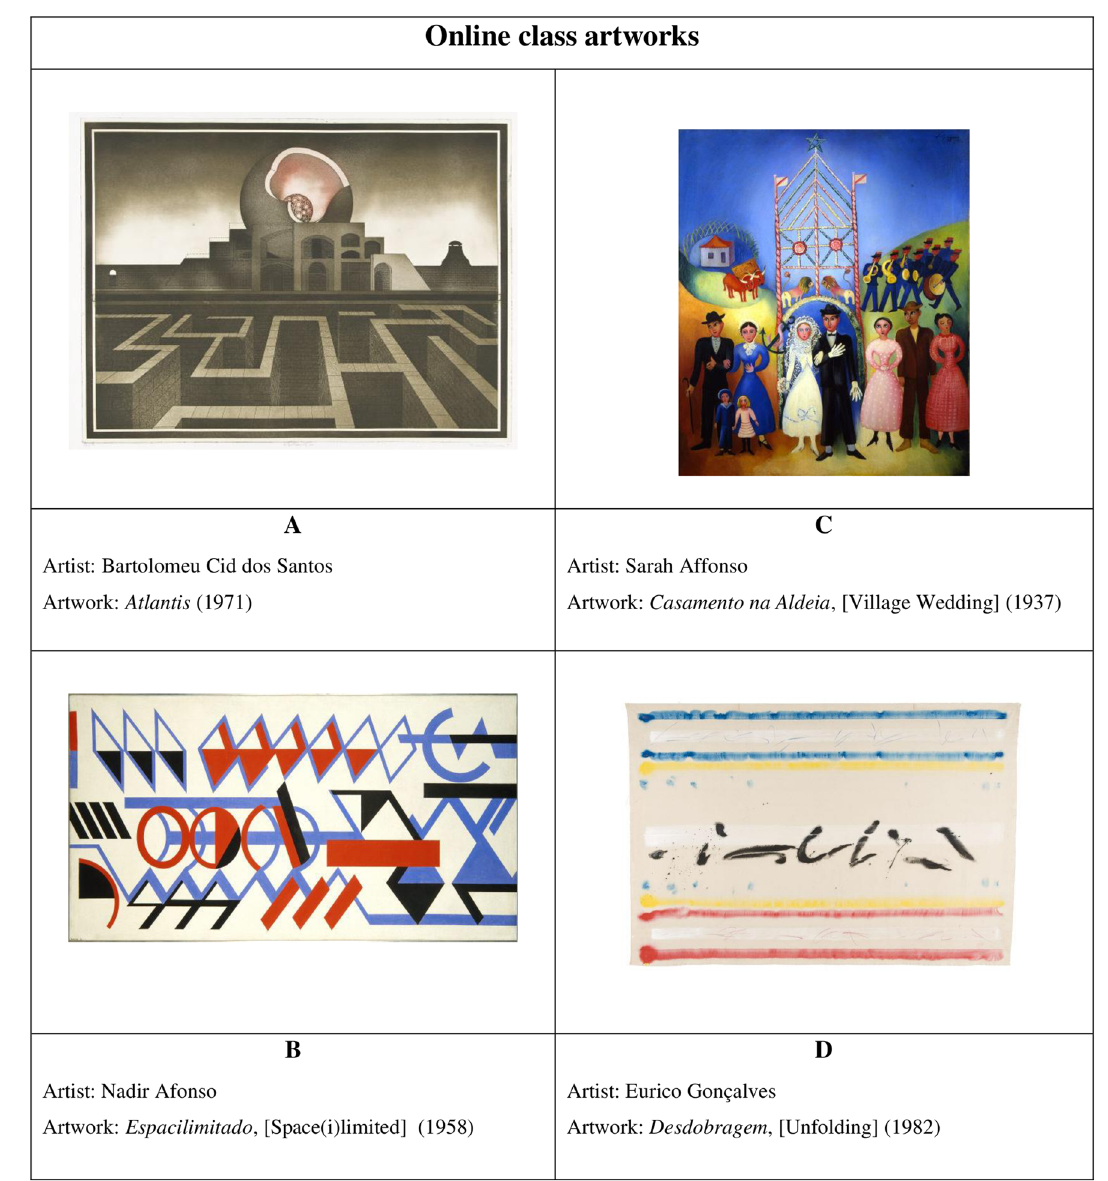
Figure 3. Selection and labelling of the 4 artworks presented at the online class.